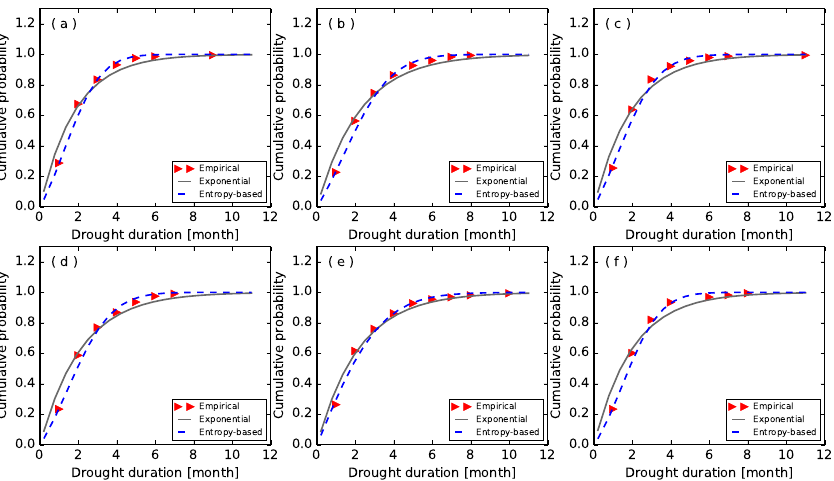
Figure 5. Cumulative distribution of drought duration at selected stations: ( a ) Changchun (station No. 54161); ( b ) Shijiazhuang (station No. 53698); ( c ) Laohekou (station No. 57265); ( d ) Maerkang (station No. 56172); ( e ) Kunming (station No. 56778); and ( f ) Jianxian (station No. 57799).